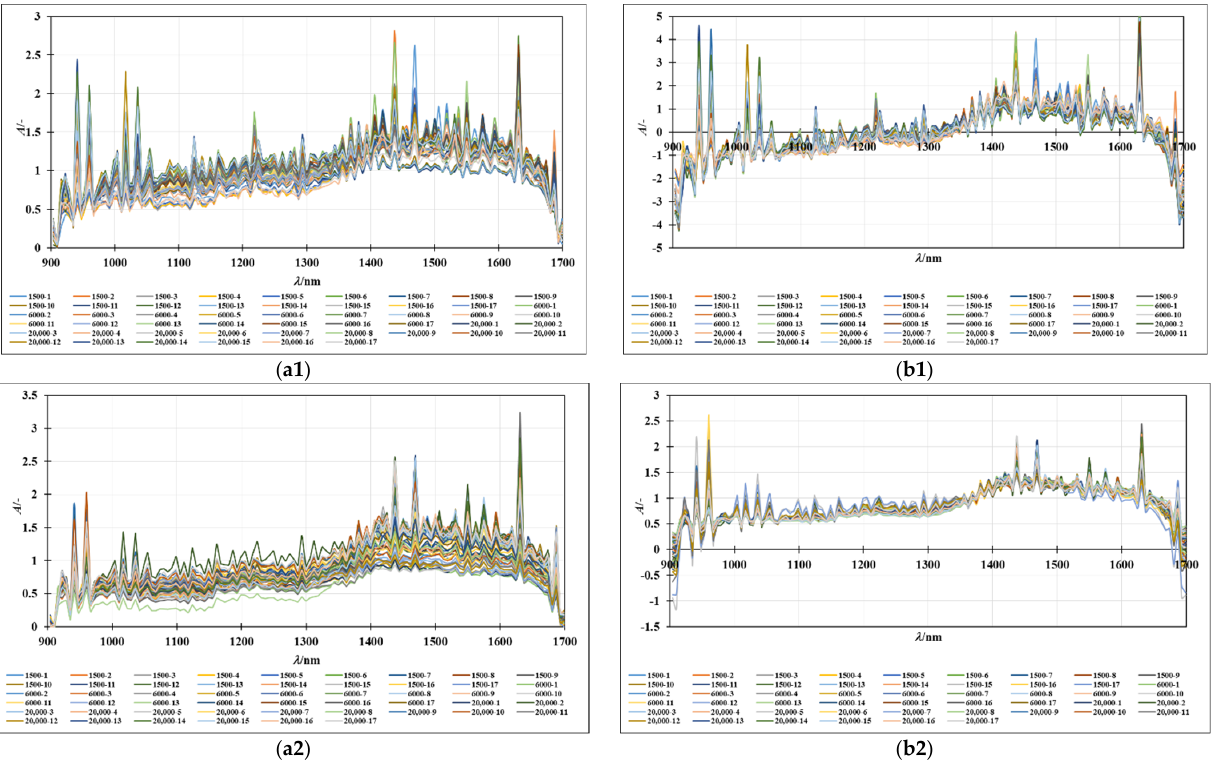
Figure 3. ( a ) Raw spectra of ( a1 ) oil-in-water and ( a2 ) oil-in-mint aqueous extracts. ( b ) ( b1 ) SNV preprocessed spectra of oil-in-water emulsions and ( b2 ) MSC preprocessed spectra of oil-in-mint aqueous extract